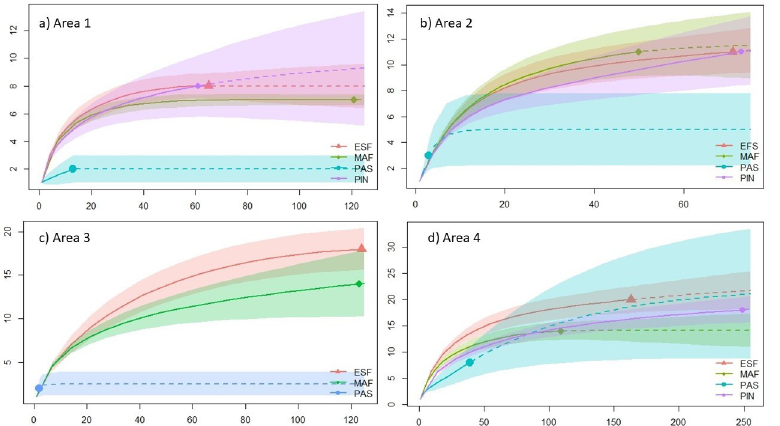
Fig 1. Rarefaction and extrapolation with Hill Numbers (q = 0) (y-axis = Species diversity (q0); x-axis = abundance) for species taxonomic richness in Mature forests (MAF), Early succession forests (ESF), Pinus monoculture (PIN) and Pastures (PAS) (a) Area 1 in Bom Retiro, SC (b) Area 2 in Bom Retiro, SC (c) Area 3 in Rancho Queimado, SC (d) Area 4 in Rancho Queimado, SC, southern Brazil.